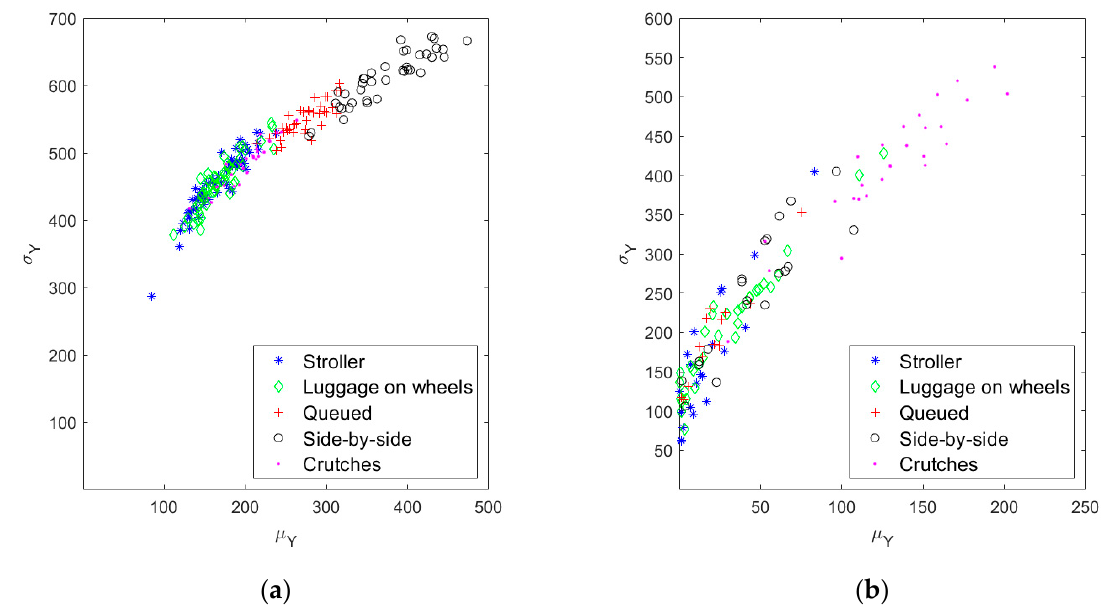
Figure 11. ( a ) Mean and variance of Y people coordinate after people extraction; ( b ) mean and variance of Y spot coordinate after pressure spot extraction.